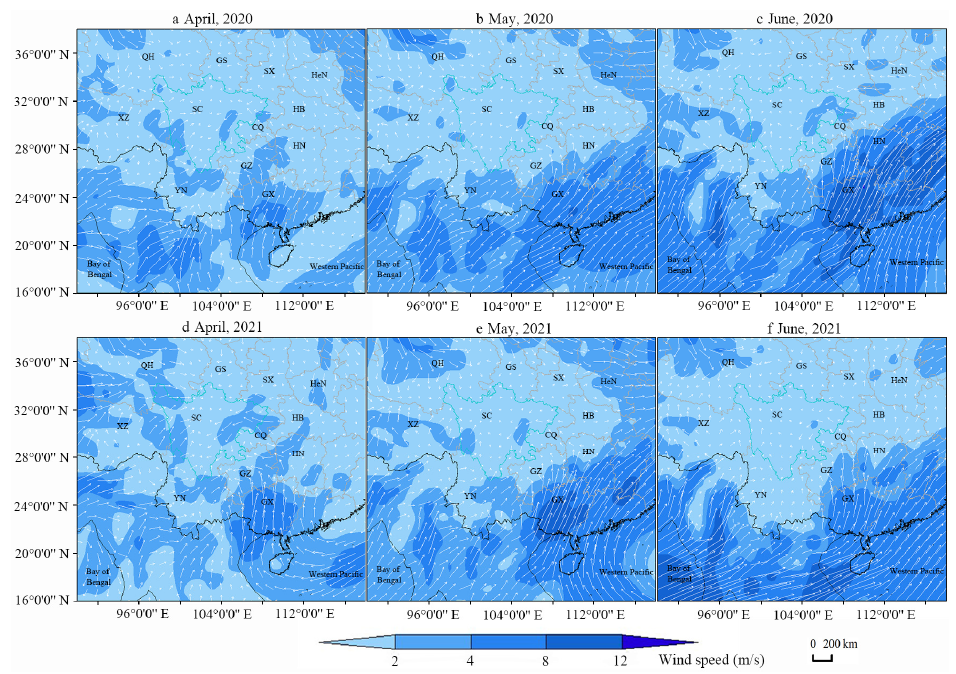
Figure 4. Average wind field at 850 hPa from April to June in 2020 and 2021. The white arrow shows the wind direction and wind speed. The longer and denser the arrows are, the higher the wind speed. The blue color shows the wind speed. Two-letter codes refer to the different provinces of China